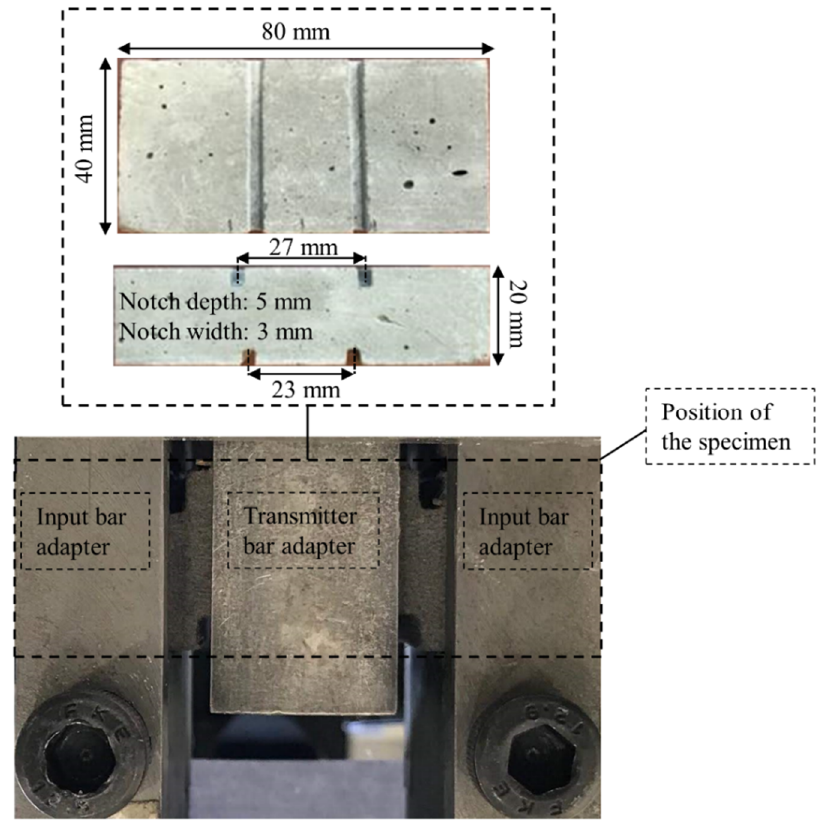
Figure 4. Geometrical details of the specimens tested under shear loading.